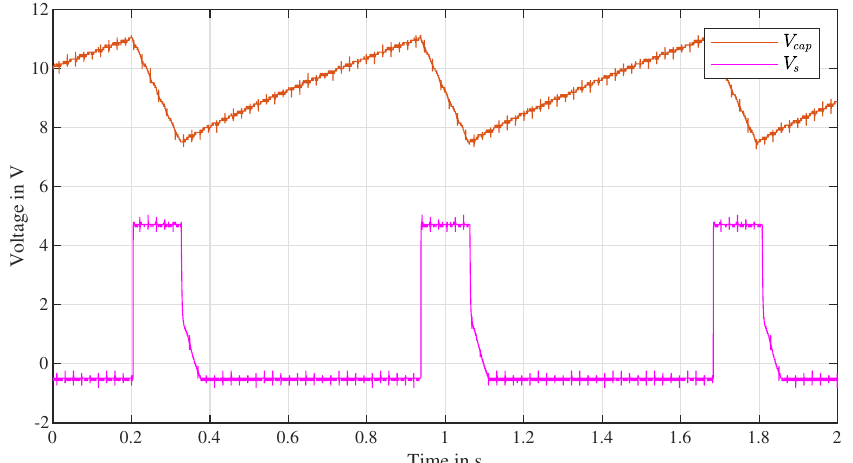
Figure 13. Voltages across the capacitor C s ( V cap ) and the signal V s measured on our prototype.